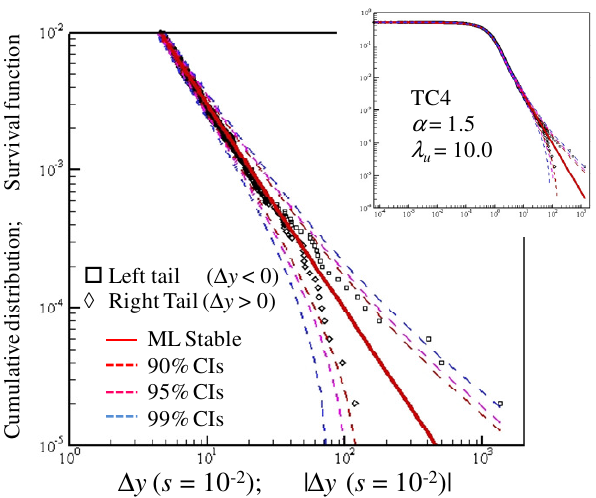
Fig. 5. Cumulative distribution versus | 1y | for 1y < 0 and survival function versus 1y for 1y > 0 of TC4 at s = 10 − 2 . Main figure emphasizes behaviour at tails. Solid curves represent ML fitted sta- ble distribution; dashed curves indicate confidence intervals,